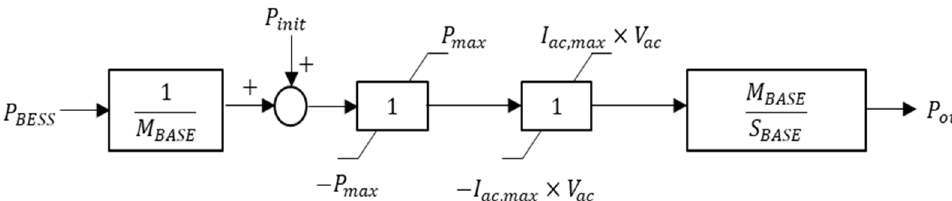
Figure 6. CBEST-based BESS dynamic model.